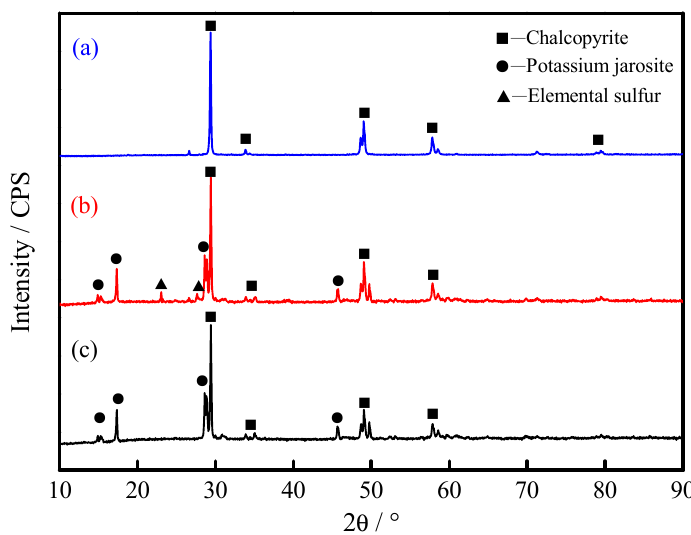
Figure 6. XRD analysis of ( a ) the original chalcopyrite, and the chalcopyrite bioleached ( b ) without Triton X-100 and ( c ) with Triton X-100. (Chalcopyrite 1% ( w / v ), Triton X-100 30 mg · L − 1 , initial cell density 2 × 10 7 cells · mL − 1 , initial Fe 2+ 0 g · L − 1 , initial pH 2.0, rotational speed 160 rpm, temperature 30 °C, and leaching for 24 days).